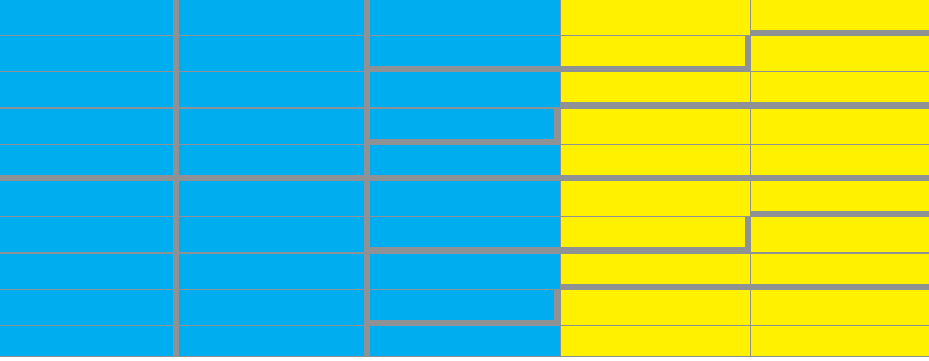
Fifty voting precincts are to be apportioned into ten contiguous districts. Each precinct is dominated by either the Cyan or the Yellow party and each precinct has approximately the same voting population. This plan evidences the two basic gerrymandering techniques: “packing” and “cracking.” The Cyan party has suffered both. It is packed into 4 districts, creating seats effectively uncontested by the Yellow party. The remaining 10 Cyan precincts are cracked (split) across 6 districts in order to put them into a minority in each case. In consequence, while Yellow has 40% of the voters, it has majorities in 60% (6 out of 10) of the districts.